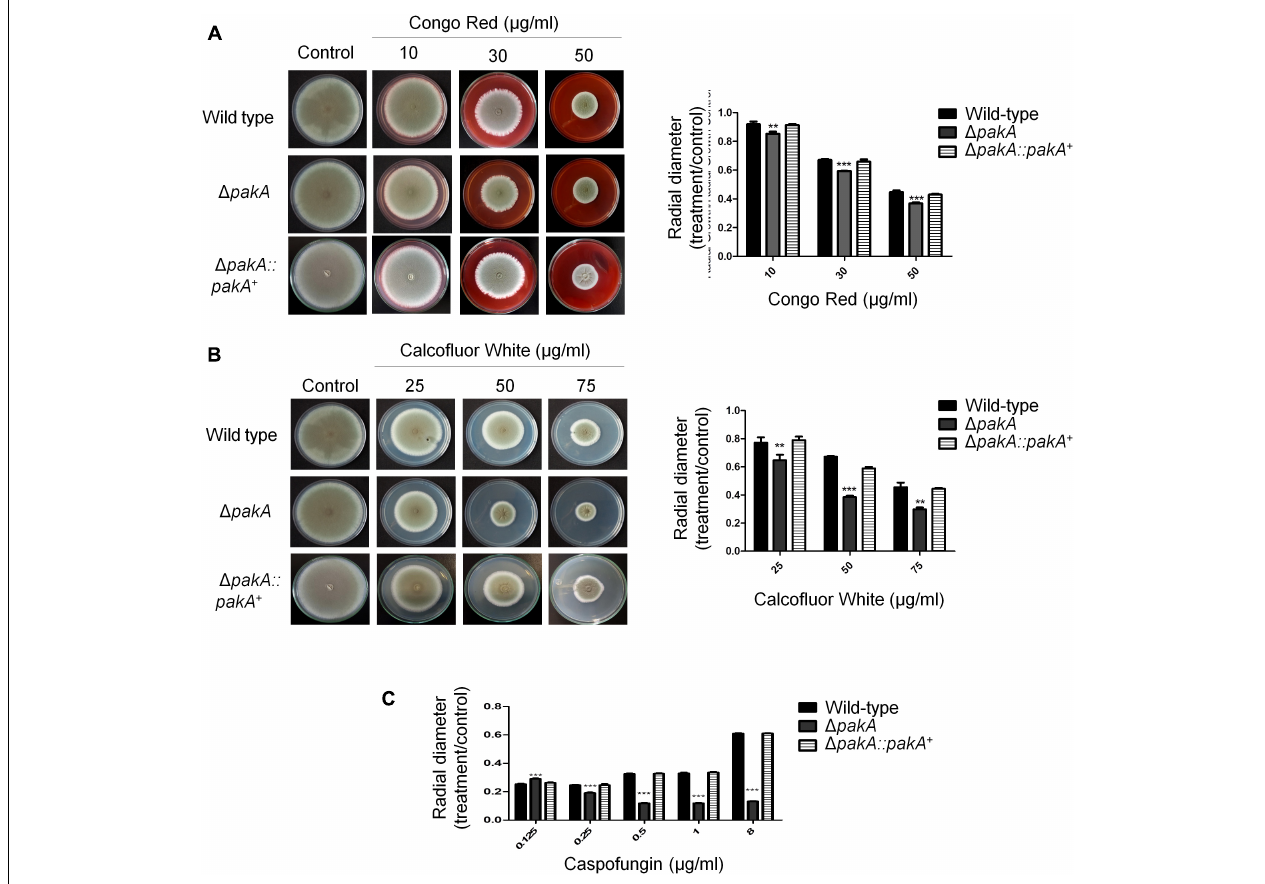
FIGURE 4 | PakA is important for the response to cell wall stress. (A) The wild-type, (cid:49) pakA, and (cid:49) paKA:pakA + and (cid:49) crzA (cid:49) zipD mutant strains were grown on minimal media with increasing concentrations of congo red (A) , calcofluor white (CFW) (B) , and caspofungin (C) for 5 days at 37 oC. The results are expressed as the average of three repetitions ± standard deviation. Statistical analysis was performed using a one-way ANOVA test when compared to the wild-type condition ( ∗∗ p < 0.005; ∗∗∗ p < 0.001).